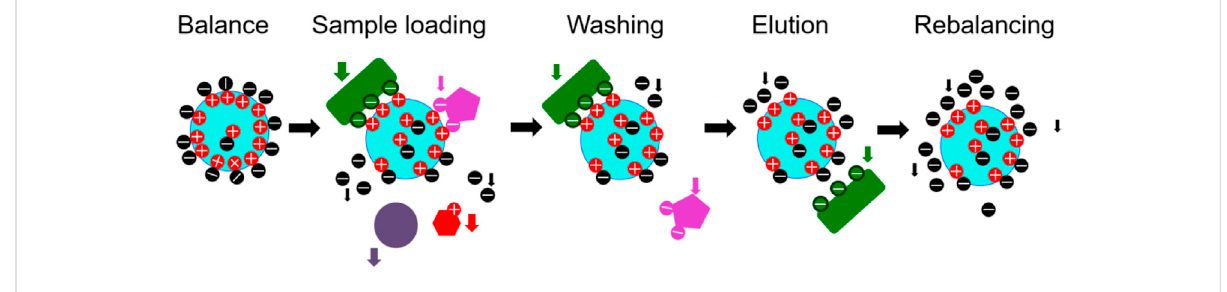
FIGURE 6 Principle of ion exchange chromatography.